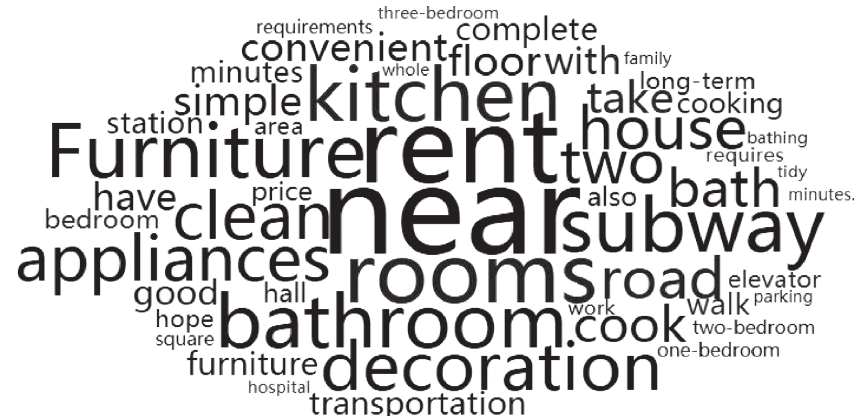
Figure 6: Word cloud diagram of rent-seeking information